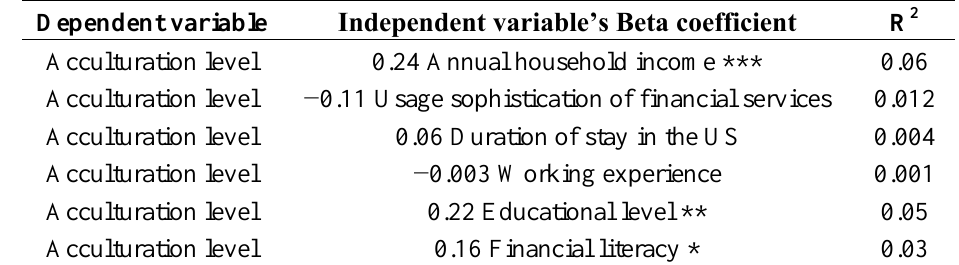
Table 3. Relationships between acculturation level and indicators of economic, cultural, and social capitals for Mexico-born